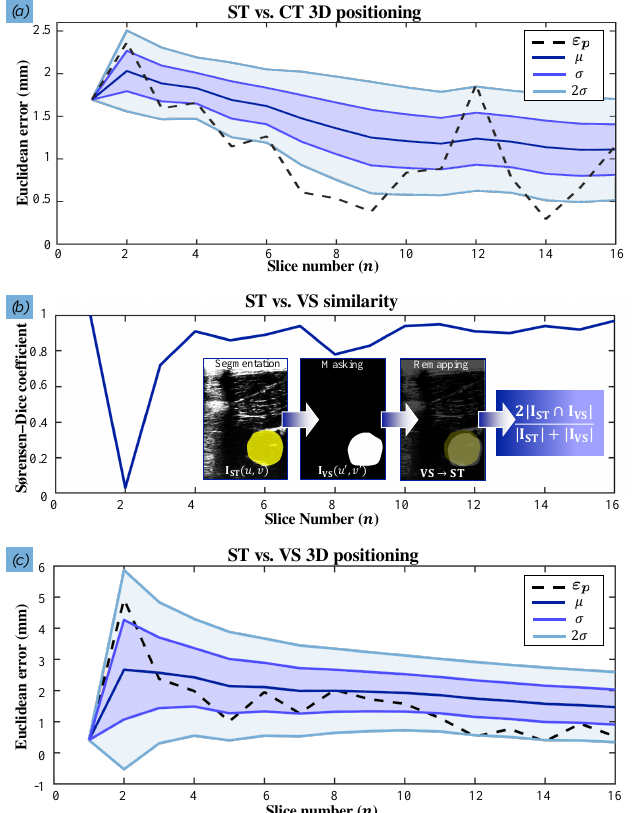
Figure 5. Calculating the reconstruction accuracies: The US images are paired as slices pertaining to each via-point on the skin surface in the transducer frame ( ). Dice similarities are calculated {U} between stationary (ST) US slices and dynamic slices captured during the visual-servo (VS) trial, both in the image reference frame ( ). Finally, the 3D Euclidean errors ( ε p ) are calculated, using {I} = i , j ) as reference point in frame ( the centroids ( c ) of each slice ( ). ∗ {P} ∗